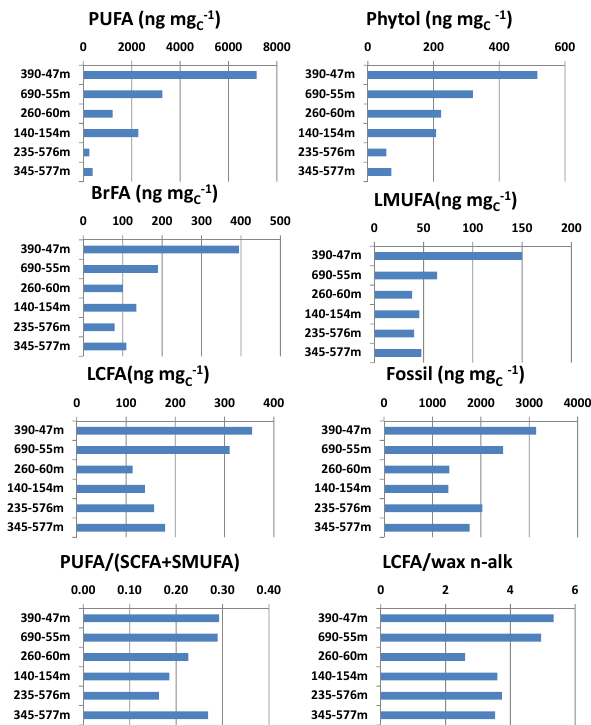
Fig. 11. TOC-normalized concentration of selected biomarkers and selected diagnostic ratios in surface sediments from the shelf, Amundsen Gulf and slope.